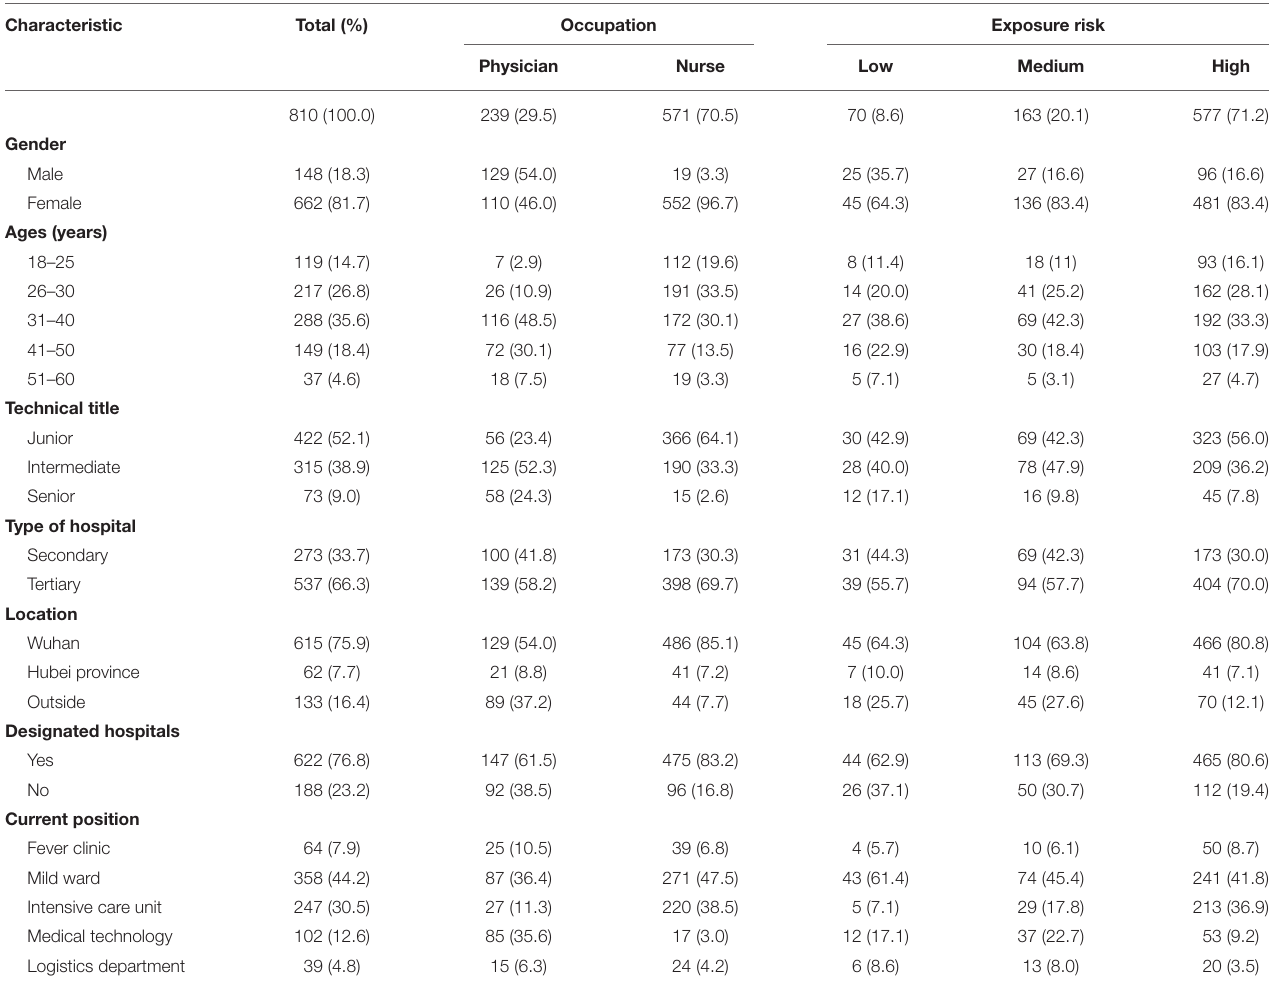
TABLE 1 | Demographic and occupational characteristics of